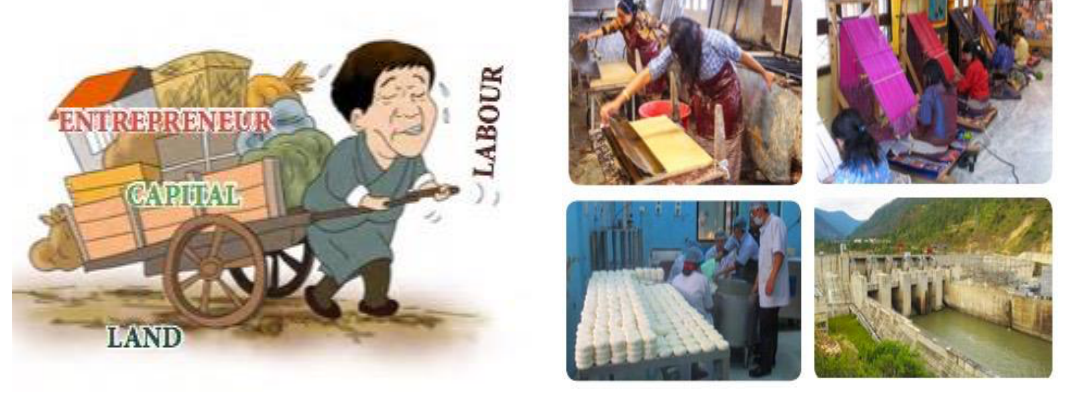
Figure 7: Images of entrepreneurship